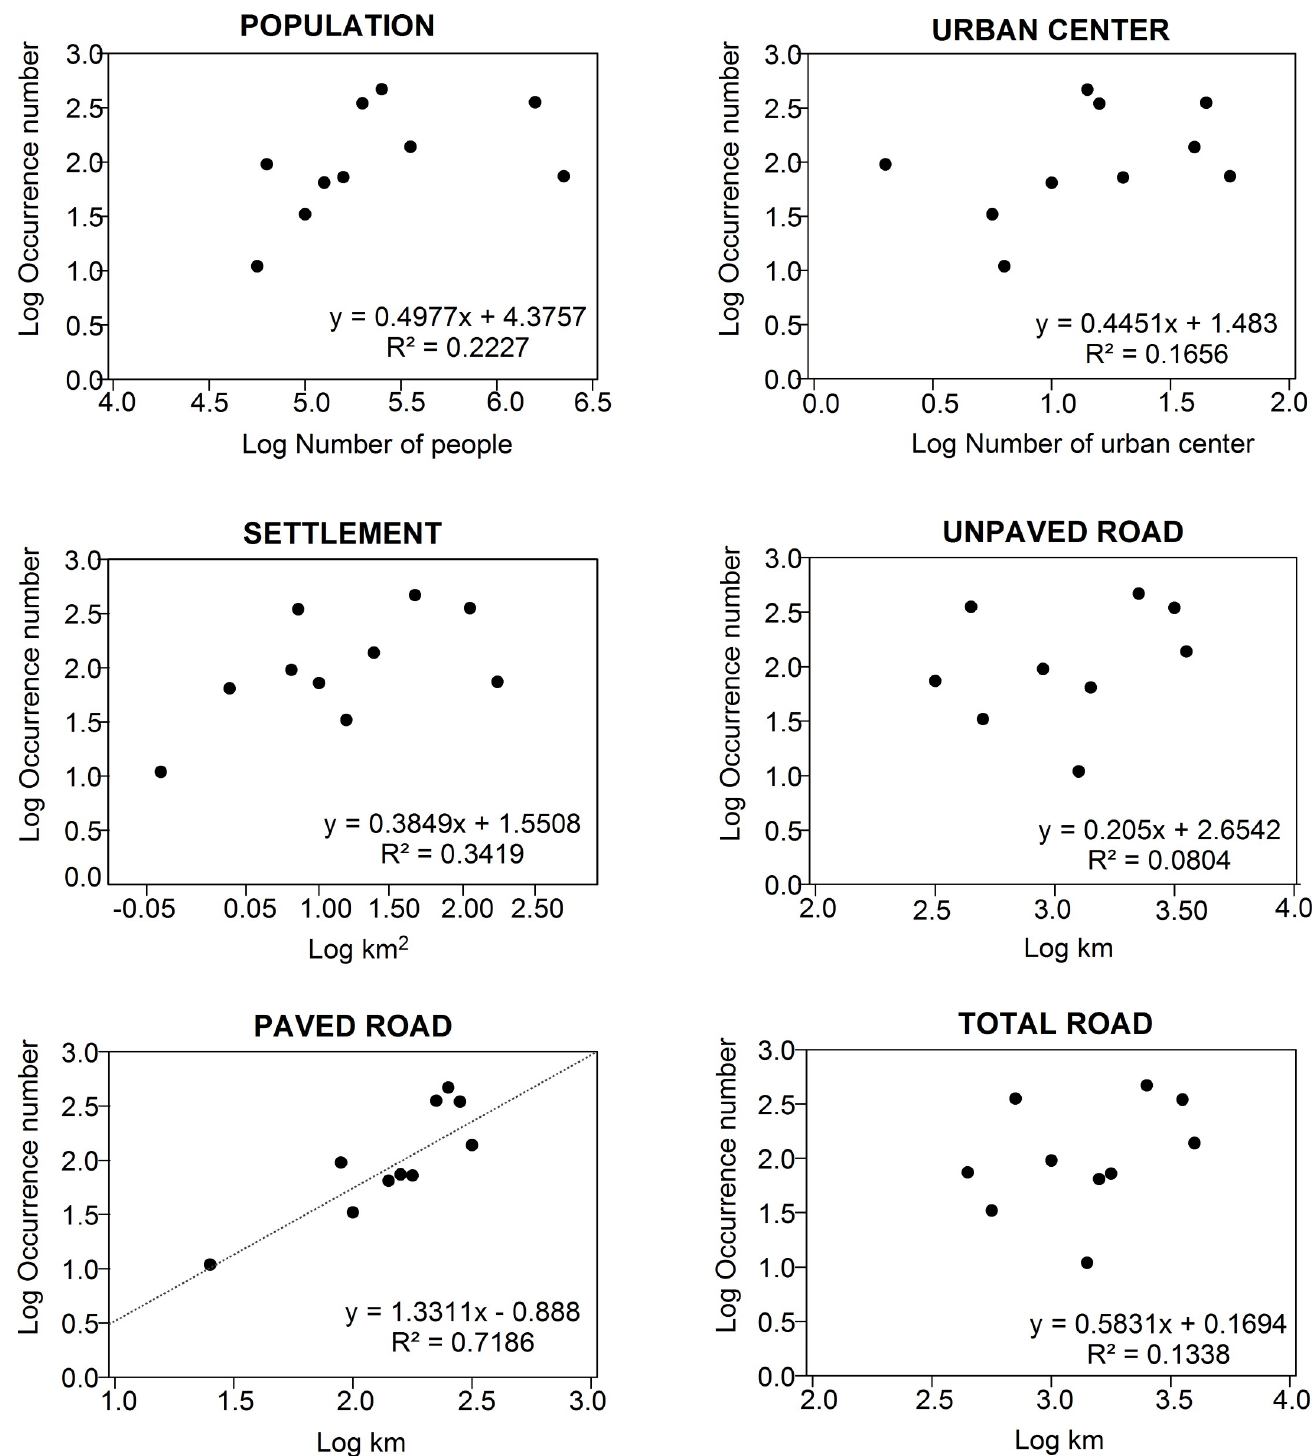
Fig 8. Relationship between the occurrence of mangrove land use and the distribution of anthropogenic drivers on the Brazilian Amazon coast.